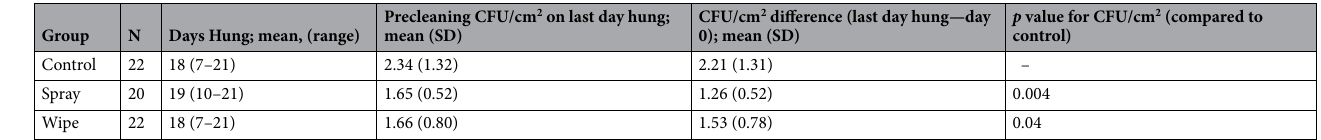
Table 1. Change in CFU/cm 2 from day 0 to last day hung.